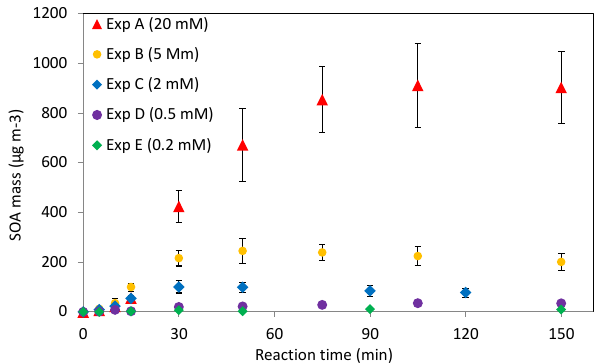
Figure 7. Influence of the initial MVK concentration on the evolu- tion of the total SOA mass obtained from the nebulized solutions. Values represent averages of three consecutive SMPS measure- ments for each reaction time considering the corresponding density (Table 3). Error bars represent the standard deviation of these aver- ages and the uncertainties of the density calculation. For the lowest initial concentrations (experiments D and E), blank signals were subtracted, and a density of 1.1gcm − 3 was